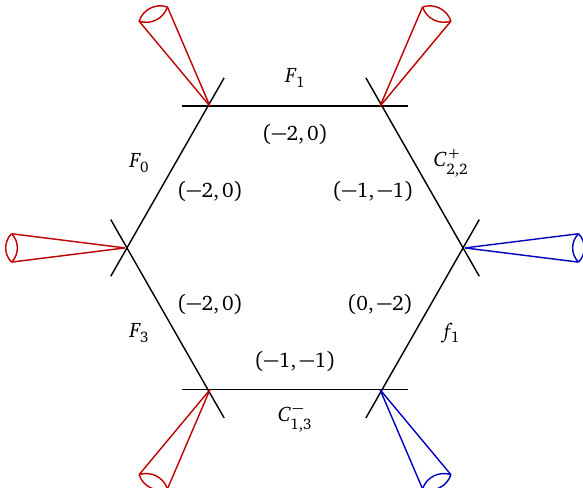
and I locus. 4 2 locus (red) and I locus 4 2